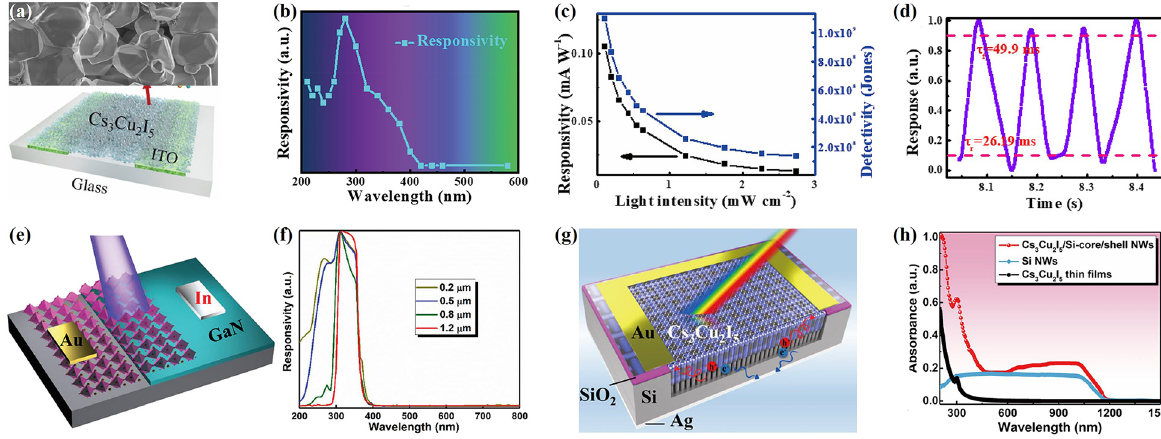
Figure 7: Cs 3 Cu 2 I 5 for UV photodetection. (a)SchematicviewoftheDUVdevice(below)andtheFESEMimageoftheCs 3 Cu 2 I 5 fi lm(above).(b)SpectralresponsivityoftheCs 3 Cu 2 I 5 -based photodetector. (c) Responsivity and detectivity of the Cs 3 Cu 2 I 5 -based photodetector upon various light intensities. (d) Response curve of the Cs 3 Cu 2 I 5 -based photodetector under a pulsed 265 nm irradiation of 20 Hz frequency. Reproduced with permission. Copyright 2019, American ChemicalSociety[101].(e)SchematicillustrationoftheCs 3 Cu 2 I 5 /GaNheterojunctiondevice.(f)Spectralresponsivityofthephotodetectorwith a collectionof layerthicknesses.Copyright2019,Royal Societyof Chemistry[28]. (g)Schematicdevicestructureof theCs 3 Cu 2 I 5